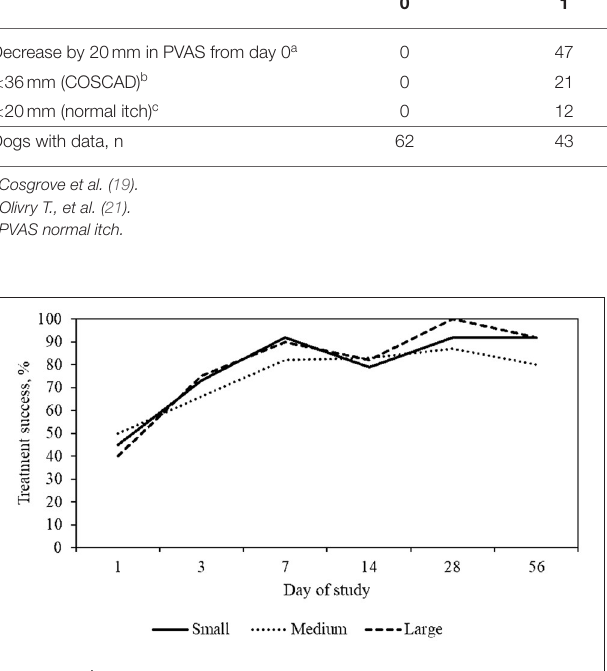
TABLE 5 | Cytopoint treatment success by three different criteria. Success criteria